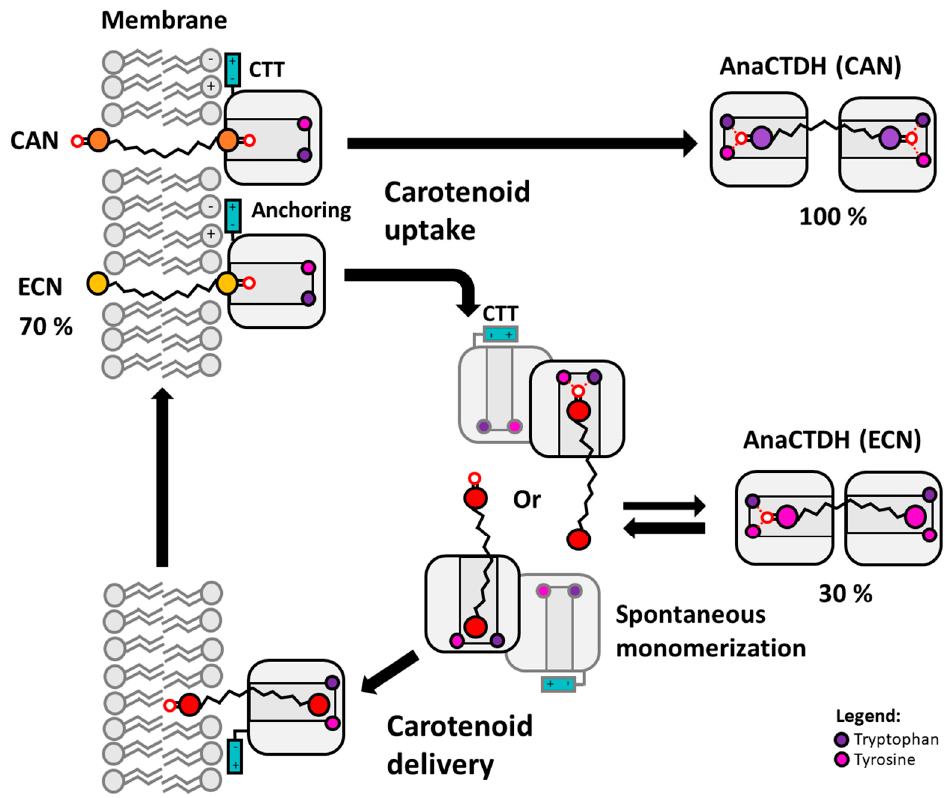
Figure 6. Proposed model for the AnaCTDH-mediated carotenoid uptake and delivery. Carotenoid uptake by AnaCTDH from the membrane is promoted by electrostatic interactions of the CTT and lipid head groups resulting in anchoring and formation of a transient complex between the membrane and the protein facing its carotenoid binding cavity towards the membrane. In such a complex, spontaneous translocation of the carotenoid into the hydrophobic part of the protein may be stabilized by the formation of the hydrogen bonds between the carotenoid keto group and the conserved Trp/Tyr residues of AnaCTDH. Due to a significant length of the carotenoid molecule, it requires two AnaCTDH subunits to isolate it from the solvent. The presence of two keto groups in CAN results in most efficient carotenoid binding in the AnaCTDH dimer, while ECN binding is apparently weaker. Since both types of AnaCTDH holoproteins can transfer carotenoids into other proteins, we postulate that intermediary, spontaneous monomerization of the protein dimer occurs regardless of the carotenoid type [24]. However, only AnaCTDH monomers in which keto group of ECN loses connection with the protein give the carotenoid an opportunity to escape another protein subunit and return to the membrane.